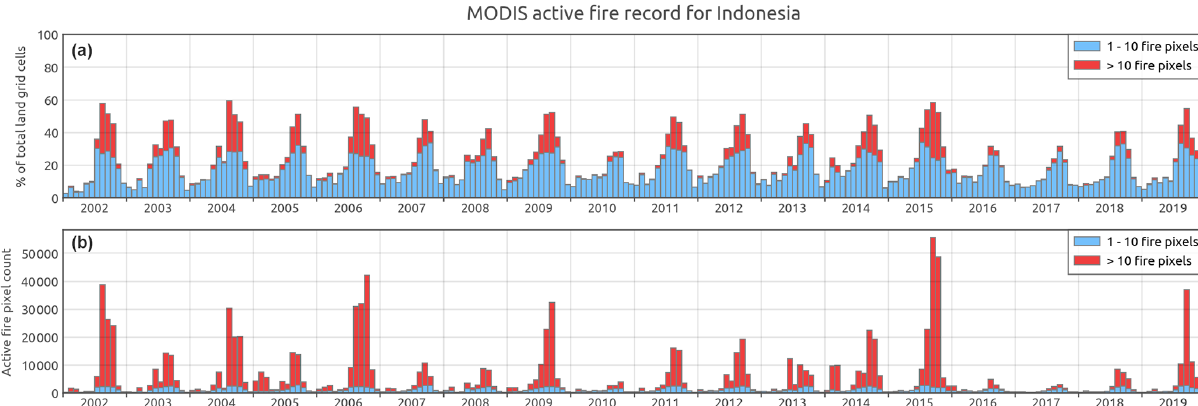
Figure 2. MODIS active-fire record for Indonesia during the 2002–2019 period. (a) Percentage of total land grid cells in the study region ( n = 2080) with active-fire detections. The two categories shown are for grid cells with relatively low fire counts (1–10 fire pixels per month) and a higher degree of fire presence ( > 10 fire pixels) in blue and red colours, respectively. (b) Total monthly MODIS active-fire counts attributable to grid cells of the two